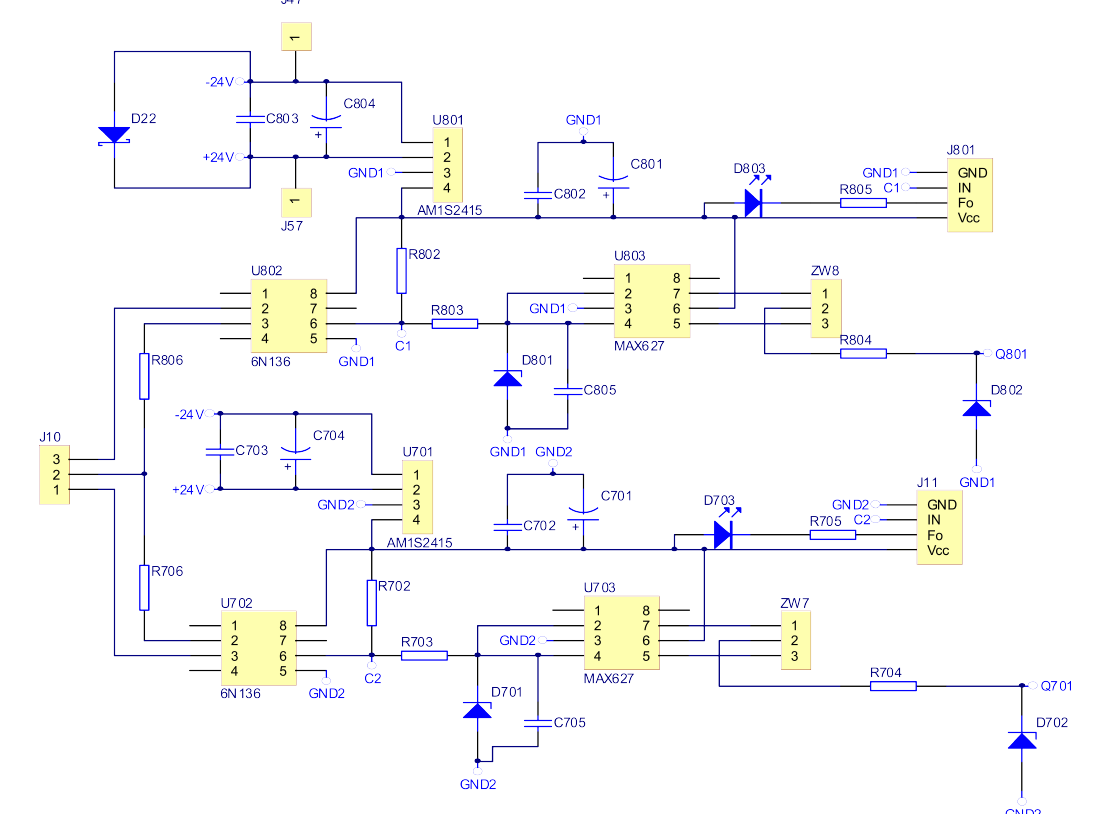
Figure 18. Schematic diagram of the DC/DC converter